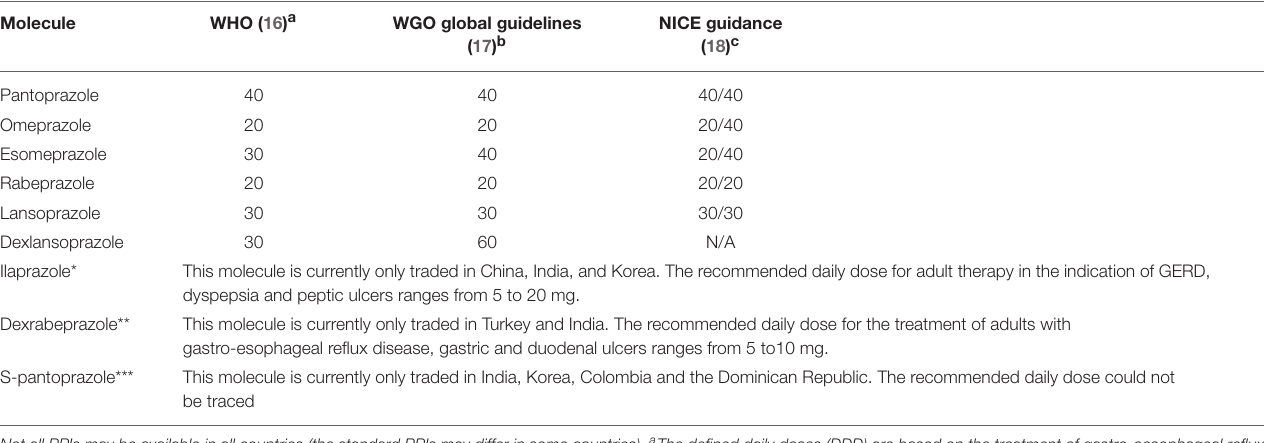
TABLE 1 | Overview of all the world’s traded PPIs (in the period of 2016–2018) and their evipotent doses (mg) for oral administration.